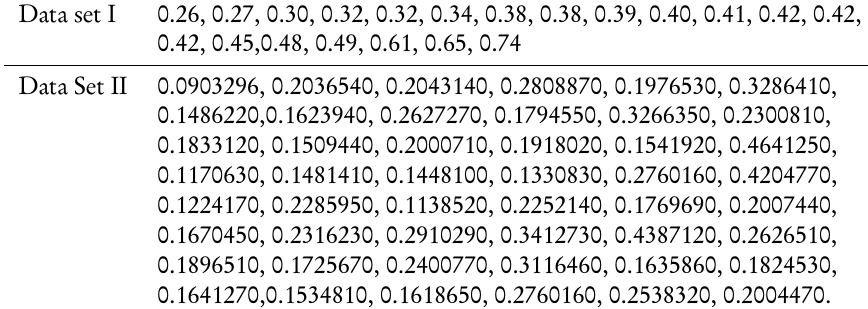
Flood Level and Rock Sample Data